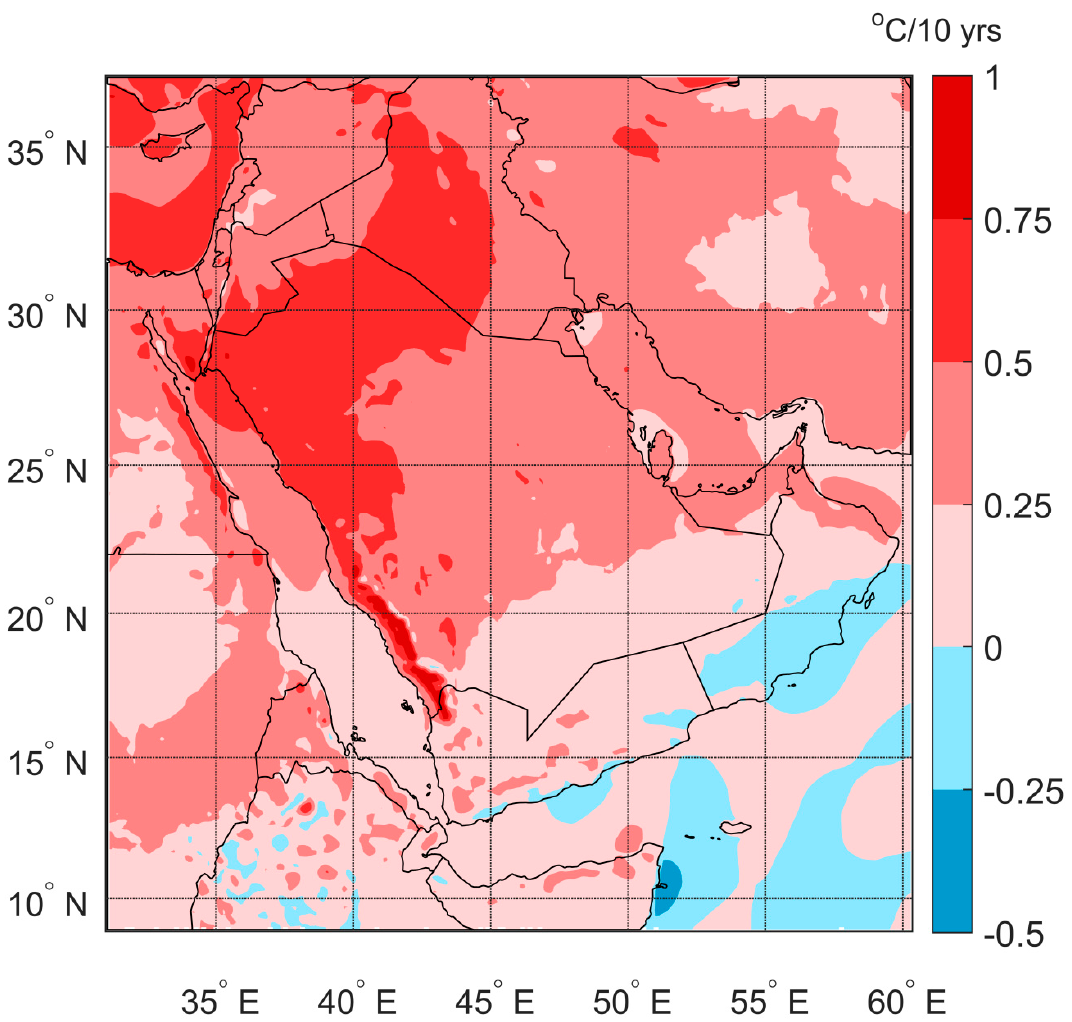
Figure 17. Daily minimum temperature change per 10 years (yrs).